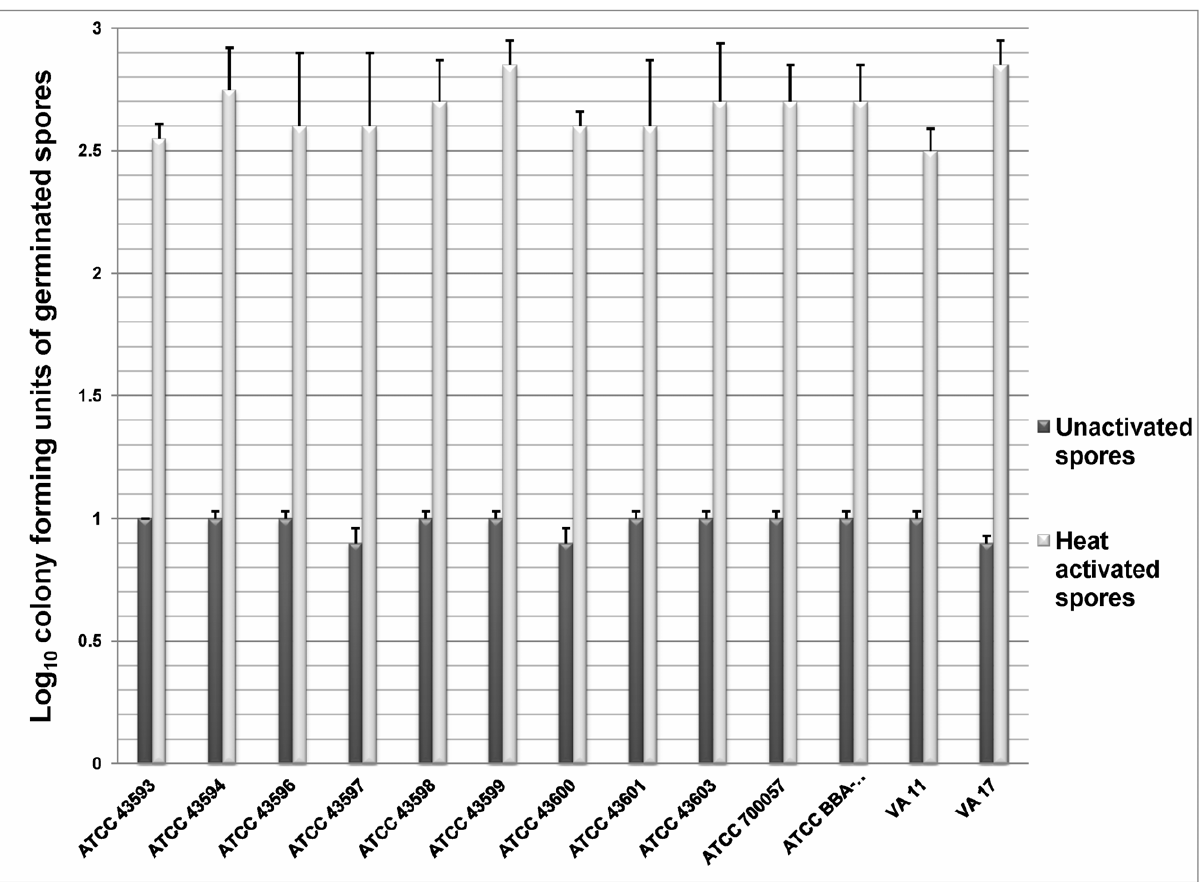
Figure 1. Germination in unactivated and heat activated C.difficile spores. The log 10 CFU of unactivated and heat activated spores that germinated in the comprehensive germination medium (Table 1) after 30 minutes of incubation under ambient conditions. Spores were confirmed as dormant or germinated by phase contrast microscopy, heat susceptibility (80 u C for 5 minutes) and a modified Wirtz-Conklin stain. The means of the data from experiments conducted in triplicate are presented. Error bars indicate standard